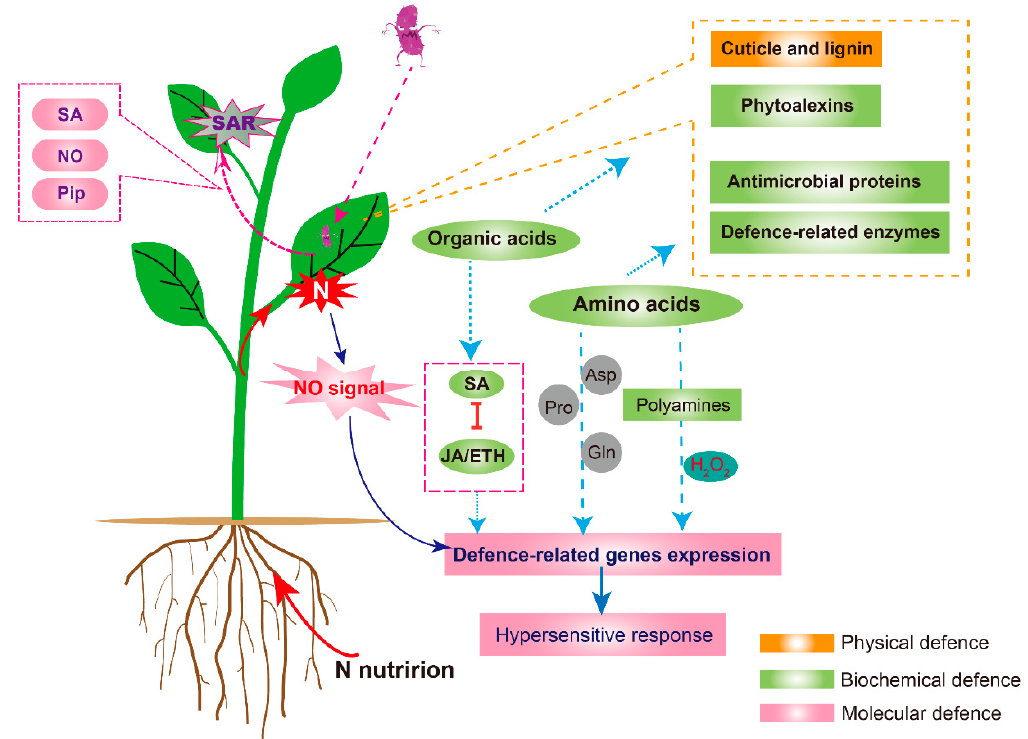
Figure 2. Proposed model for the interaction between nitrogen (N) nutrition and plant physical, biochemistry and molecular defences. N nutrition is involved in the construction of the plant defence system, including the defined negative effects on physical defences and phytoalexins contents and the positive effects on antimicrobial proteins. N also mediates phytoalexin formation and downstream hypersensitive response via the amino acid metabolism. In addition, N nutrition can also regulate hormone (salicylic acid, SA; jasmonic acid, JA and ethylene, ETH) status and the subsequent defence genes expression patterns through organic acid metabolism or the function of nitric oxide (NO). NO signal is an important bridge between N nutrition and plant disease resistance, which is tightly linked to N forms. Notably, pipecolic acid (Pip) derived from lysine (Lys), NO signal, and SA can also mediate the distant systemic acquired resistance (SAR) together with reactive oxygen species (ROS), which is critical for plant survival when facing diseases.